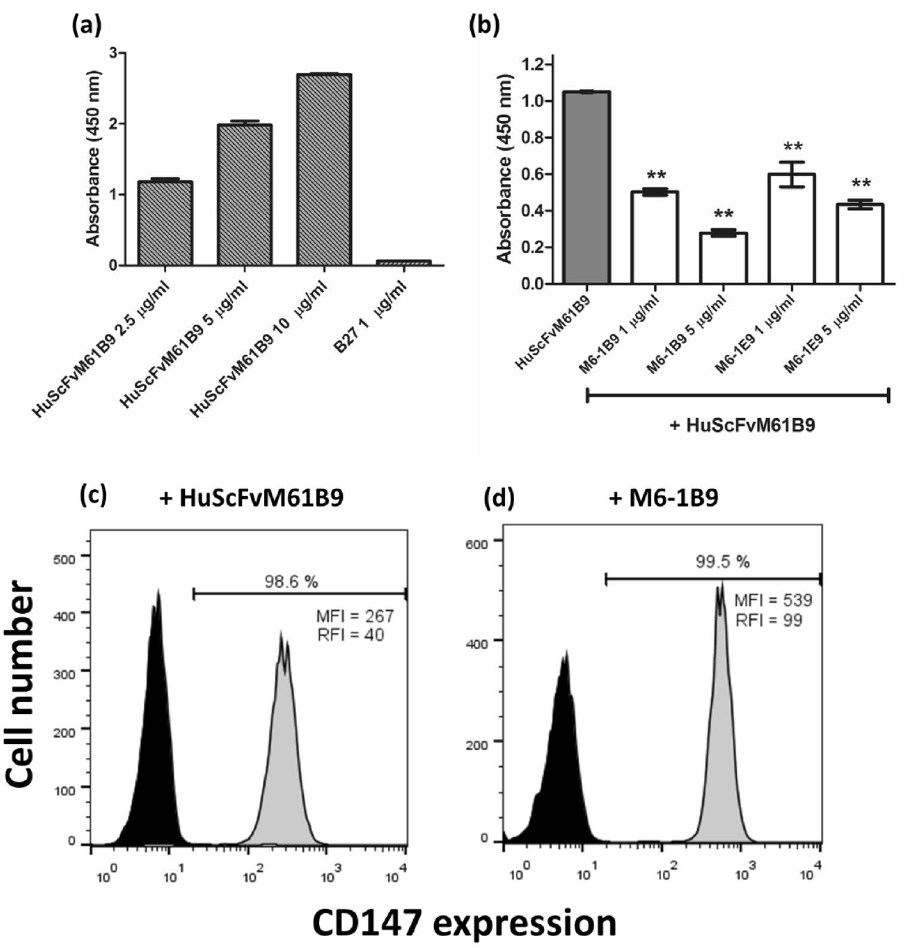
Figure 8. Immunoreactivity of HuScFvM61B9. ( a ) The microtiter plates were coated with CD147Rg, and HuScFvM61B9 was subsequently added at various concentrations to analyze the binding activity of HuScFvM61B9. HuScFvM61B9 was detected by HRP-conjugated anti-His-tag mAb. B27 was used as an irrelevant antibody control. ( b ) The ELISA wells were coated with CD147Rg, and mouse anti-CD147 mAbs were used to inhibit the binding of HuScFvM61B9 to the target. The signal was determined using HRP-conjugated anti-His-tag mAb, and the absorbance was measured using a microtiter plate reader. The data illustrate triplicate experiments and an error bar (mean ± SD), analyzed by a paired t-test (**p < 0.01). Immunofluorescence analysis of the reactivity of HuScFvM61B9 ( c ) and M6-1B9 ( d ) to CD147 on SupT1 cells. PE-conjugated anti-His tag antibody and Alexa Fluor 568 conjugated goat-anti-mouse IgG (H + L) were used as secondary antibodies. The percentage of positive cells is presented over the mean fluorescence intensity (MFI) and relative fluorescence intensity (RFI)